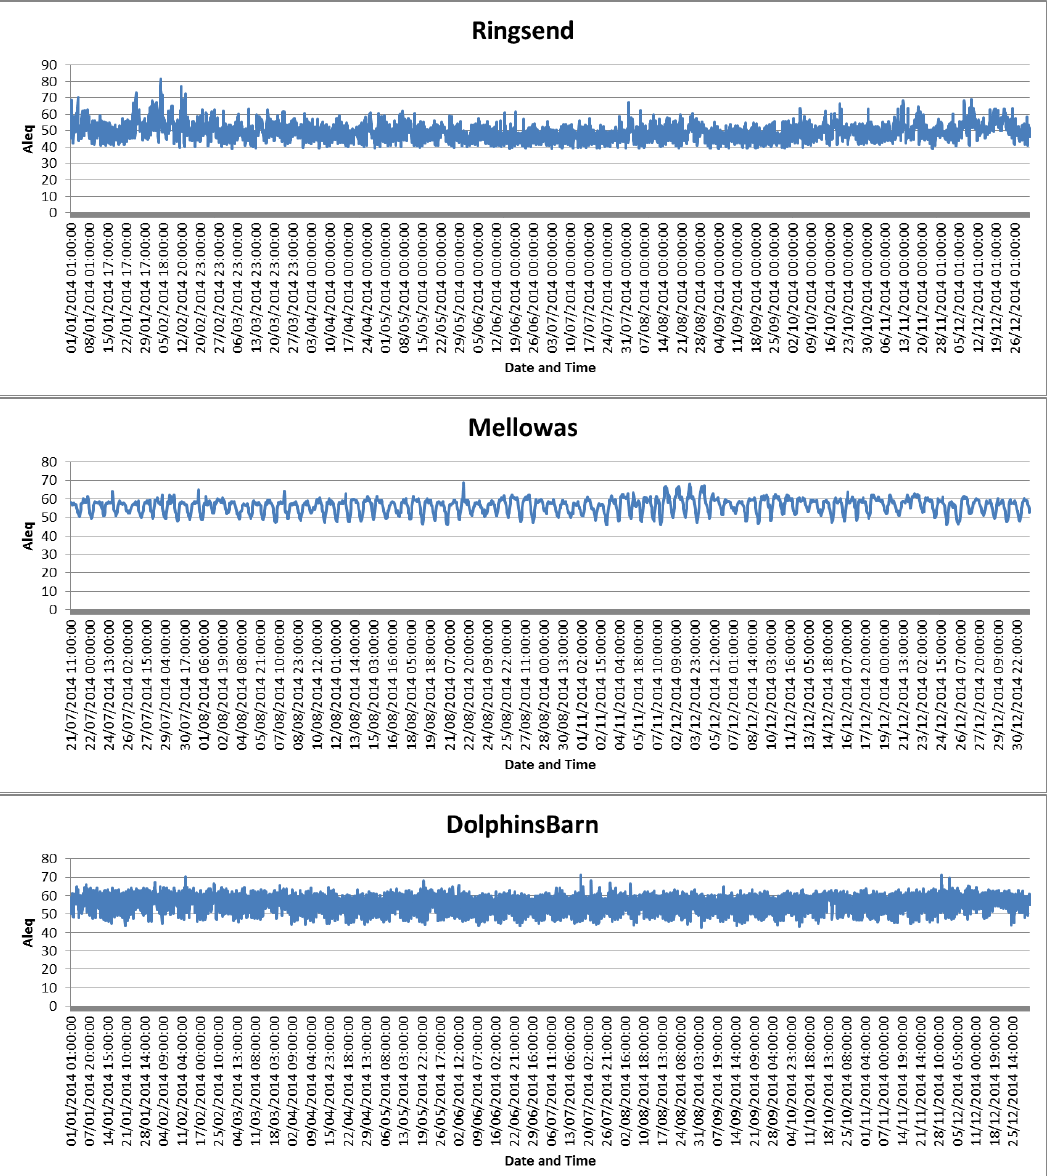
Supplementary Figure 3: AL eq at hourly resolution